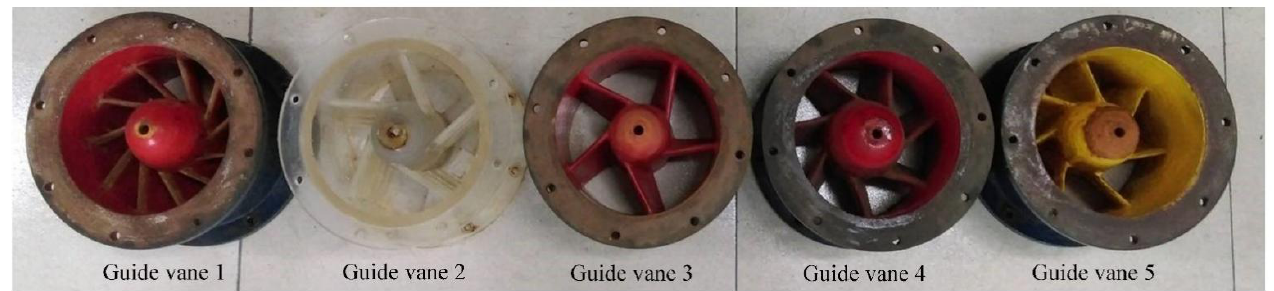
Figure 9. Series of guide vanes.